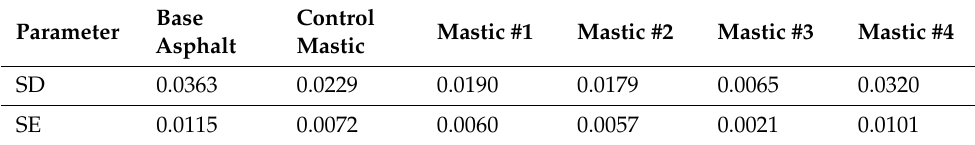
Figure 7. Emissivity results for different asphalt mastics. Table 5. Error statistics results of emissivity test.